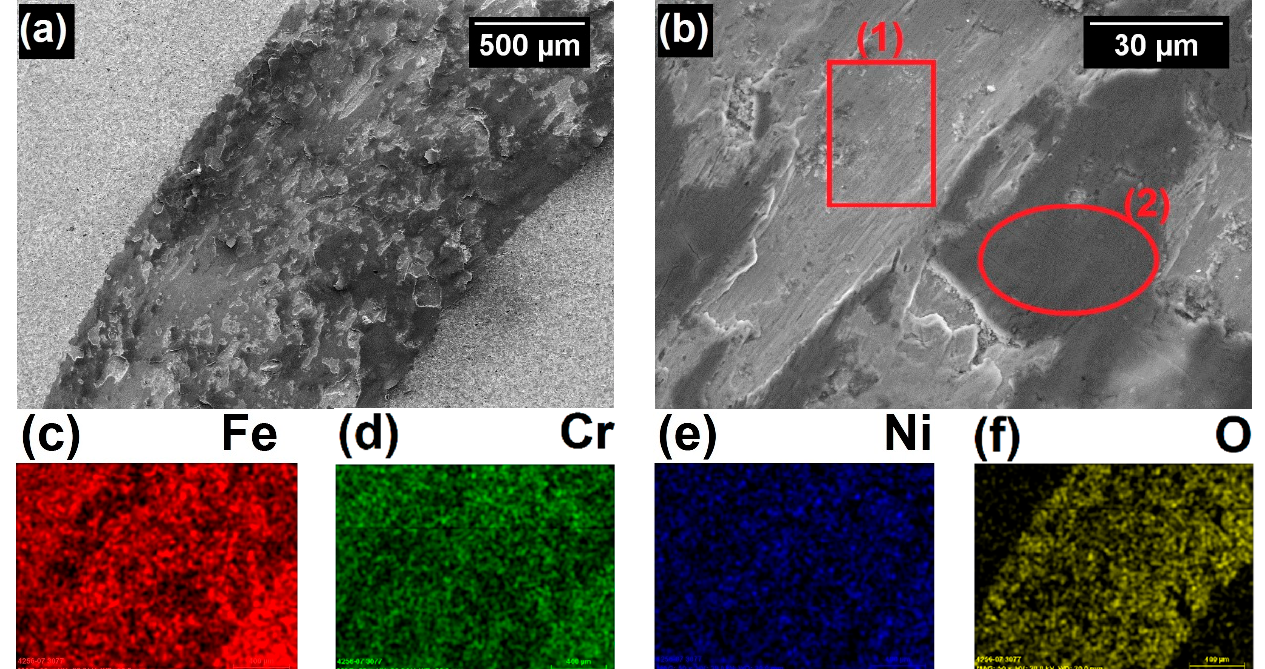
Figure 10. SEM and EDS of the 316L bulk ball-on-disk testing track. ( a ) 50 × . ( b ) 1000 × , where (1) is a region with abrasion-type wear marks and (2) is a region with adhesive-type wear. ( c – f ) EDS mappings.